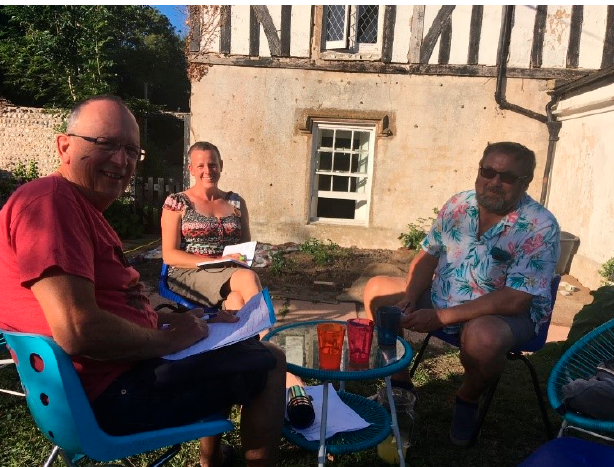
. Figure 2. First education group meeting at Langney Priory, 15 July 2019 @ P von Hellermann.